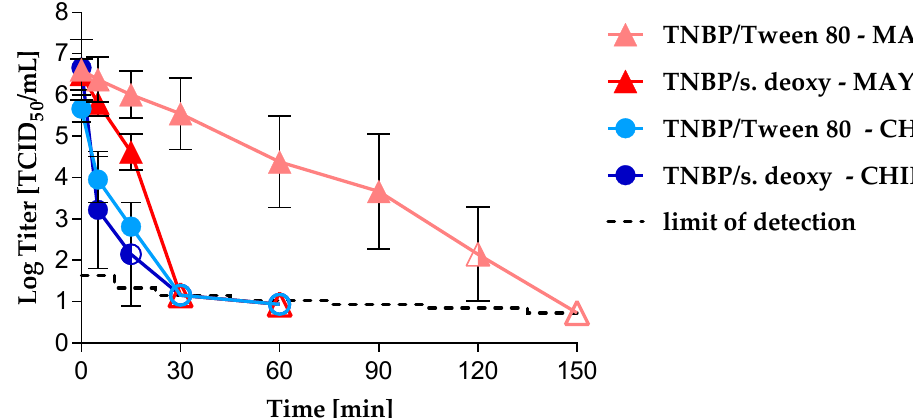
Figure 4. Inactivation kinetics of CHIKV and MAYV under S/D treatment using 0.3% TNBP/1% Tween 80 or 0.3% TNBP/0.2% sodium deoxycholate. CHIKV or MAYV were spiked into 5% albumin solution containing S/D reagents. All experiments were performed in triplicate except the MAYV S/D treatment using TNBP/Tween 80 ( n = 8). Error bars represent the standard deviation. S/D-treated samples are indicated by circular (CHIKV) or triangular (MAYV) symbols. Closed symbols = infectivity was detected; open symbols = no residual infectivity was detected; half-open symbol = in 4/8 (MAYV) or 1/3 (CHIKV) experiments, residual infectivity was detected; the limit of detection depends on the sample volume